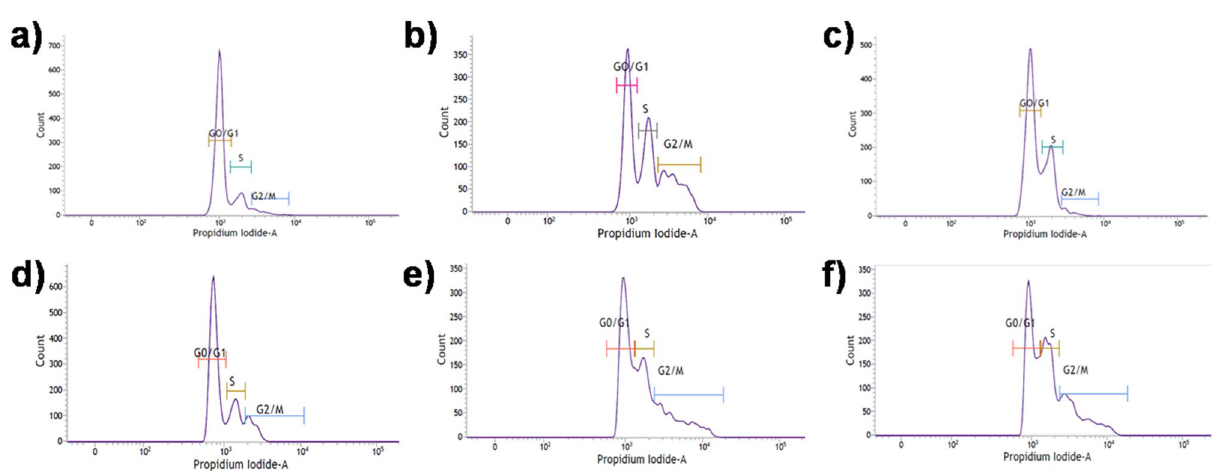
Figure 6. Cell cycle arrest induced by gold nanoconjugates in the presence of 5-ALA mediated PDT on breast cancer cells. MCF-7(a-c) and MDA-MB-231 ( d – f ) breast cancer cells. ( a ) Control (untreated cells). (b) IR-5-ALA-TPP-CTAC©AuNTs (IC 50 –0.71 ± 0.14 µg /mL). ( c ) IR-5-ALA-TPP-PSS@CTAC©AuNTs (IC 50 - 0.67 ± 0.89 µg/mL). ( d ) Control (untreated cells). ( e ) IR-5-ALA-TPP-CTAC©AuNTs (IC 50 -0.78 ± 0.55 µg/mL). ( f ) IR-5-ALA-TPP-PSS@CTAC©AuNTs (IC 50 - 0.58 ± 0.23 µg